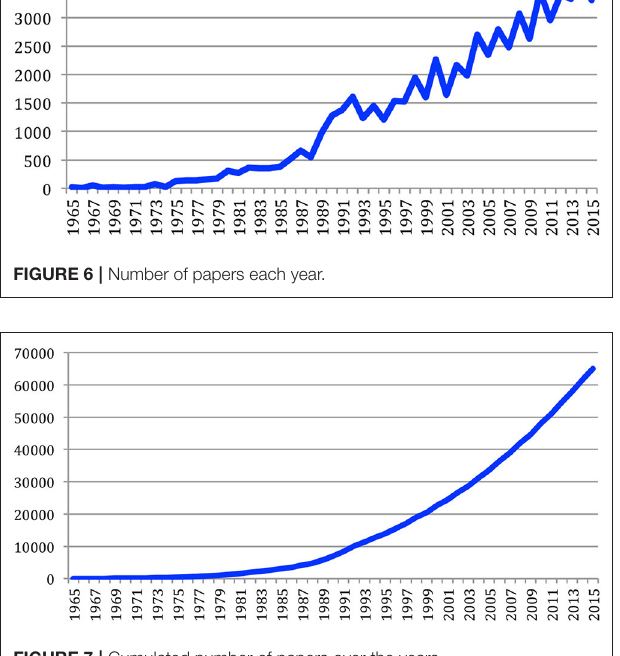
FIGURE 7 | Cumulated number of papers over the